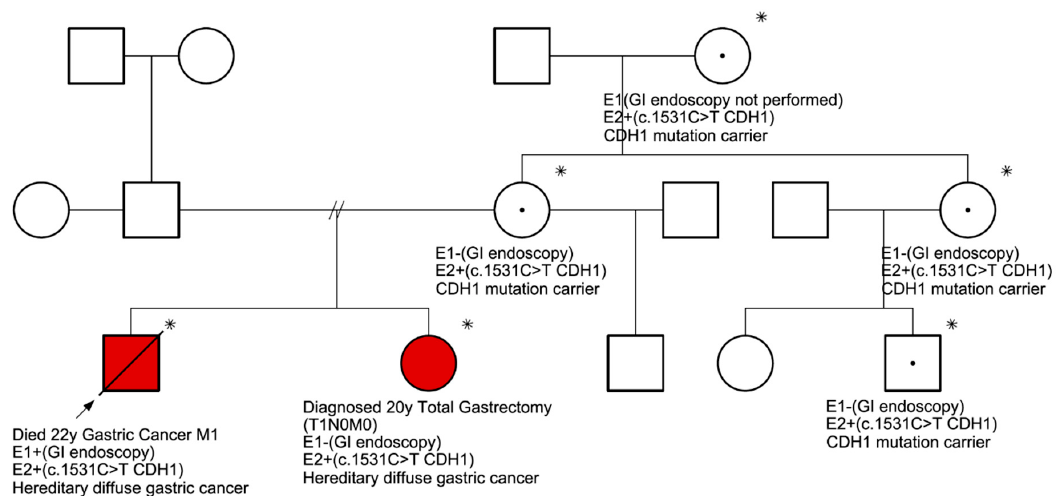
Figure 2. Family pedigree with c.1531C>T (p.Gln511*) nonsense sequence variant in six family members showing hereditary diffuse gastric cancer (HDGC) syndrome. * Patients with c.1531C>T sequence variant. : Proband. : Died from gastric cancer. : Male. : Female. E1: endoscopic evaluation. E2: molecular evaluation. In red, the two individuals in which DGC was confirmed.